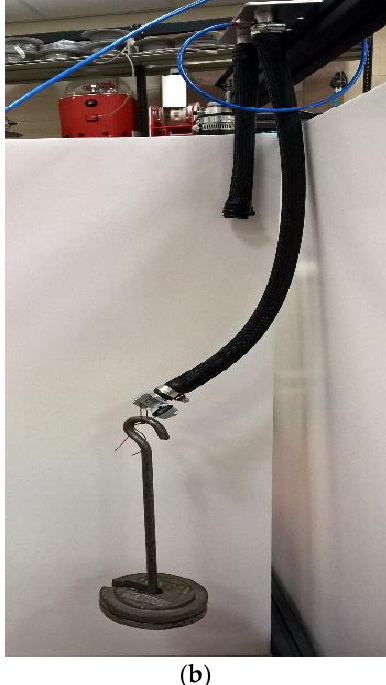
Figure 9. Three SBCAs at 500 kPa of various lengths ( a ) at no-load. ( b ) The 30 cm SBCA at 300 kPa and 1.0 kg.